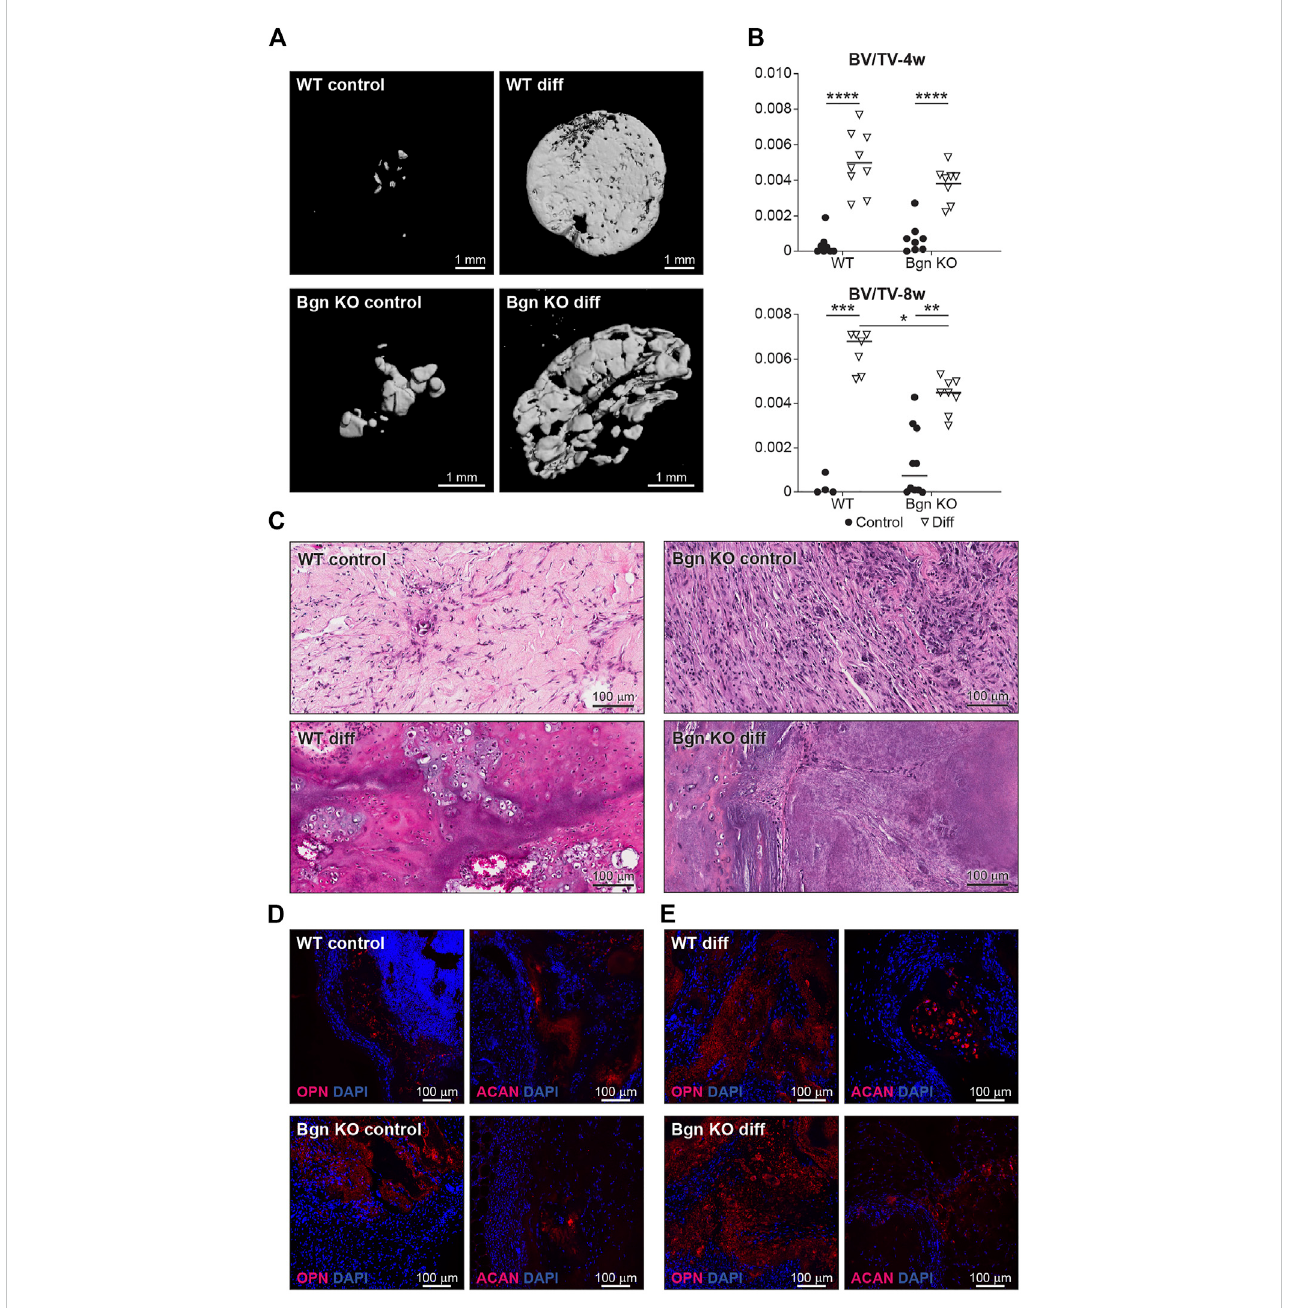
Figure S1B. All the clusters included cells originating from both WT and Bgn KO animals, but the relative distribution of Bgn KO and WT cells differed in many of the clusters (Figure 1D; Supplementary Figure S2). From the total analyzed cells, 8.6% were